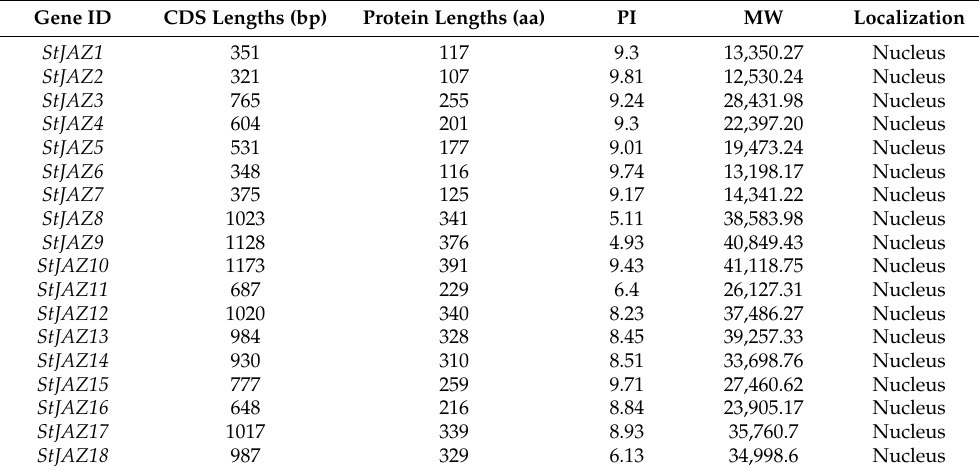
Table 1. Characteristics of 18 family members of the JAZ gene in Solanum tuberosum